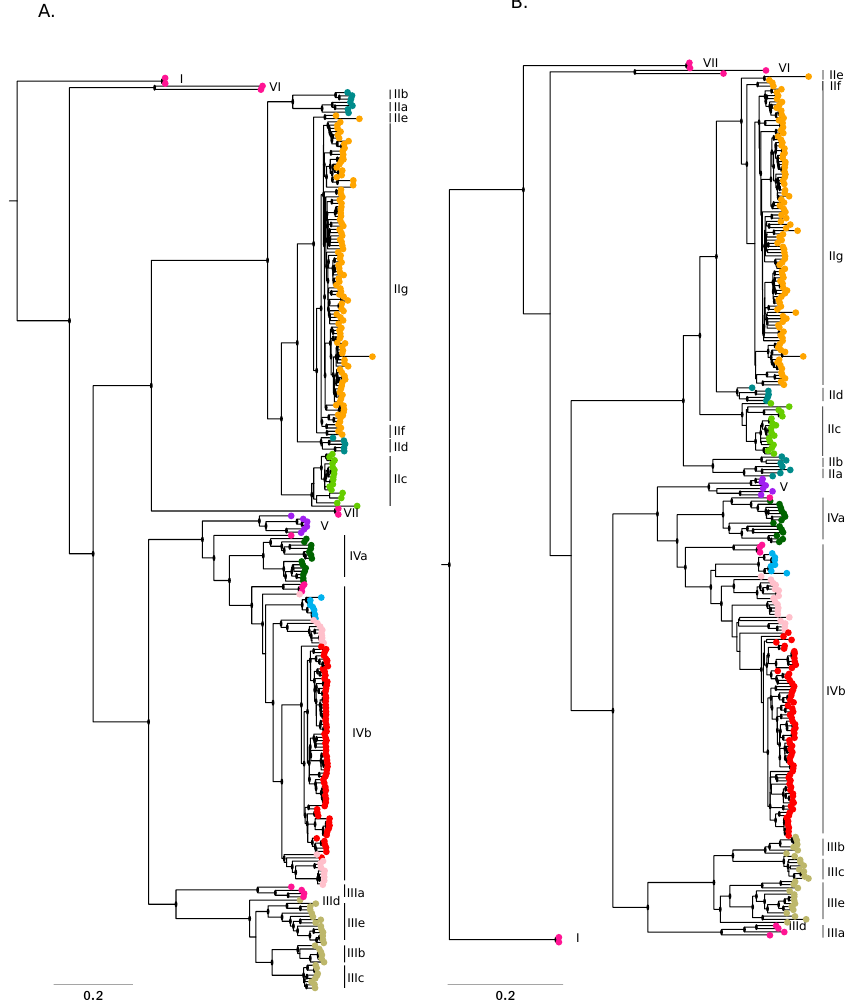
Figure 2. Phylogenetic trees. Phylogenies of the L ( A ) and S ( B ) segment were constructed using RAxML and the reference mobala virus sequence (L: NC_007904; S: NC_007903) as the outgroup. LASV sequences are colored according to the major ancestry component identified by STRUCTURE. Lineage and sublineage nomenclature is in accordance with a previous work [19]. Nodes with bootstrap support higher than 0.7 are denoted with a black